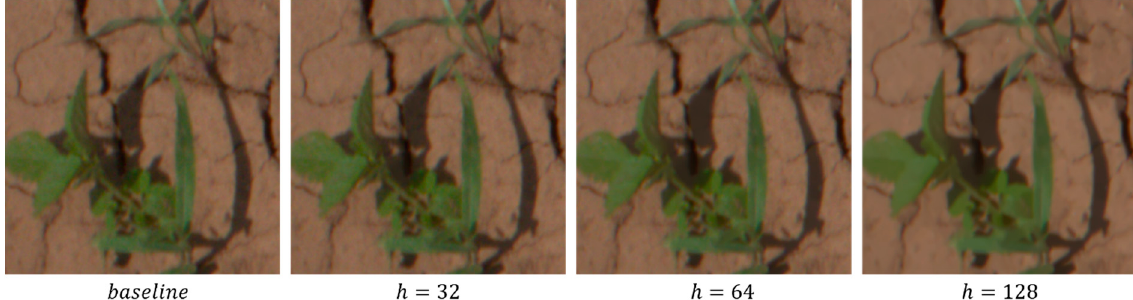
Figure 4. Example of simulated images at denoising levels of ℎ = 32, 64, and 128, in comparison to the baseline.